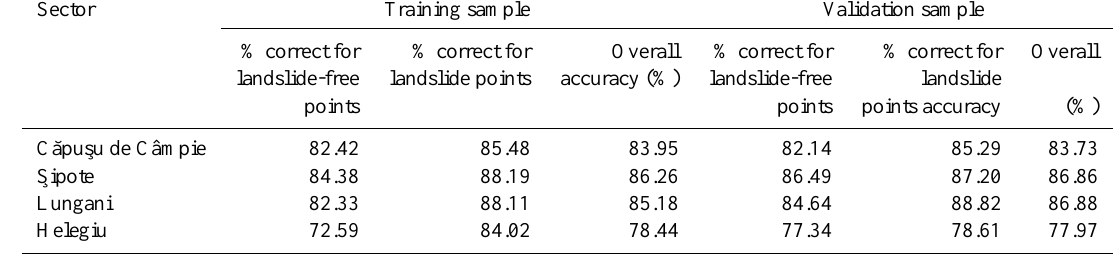
Table 6. Percentages of correctly classified points with respect to training and validation samples, using a cut-off value of 0.5.